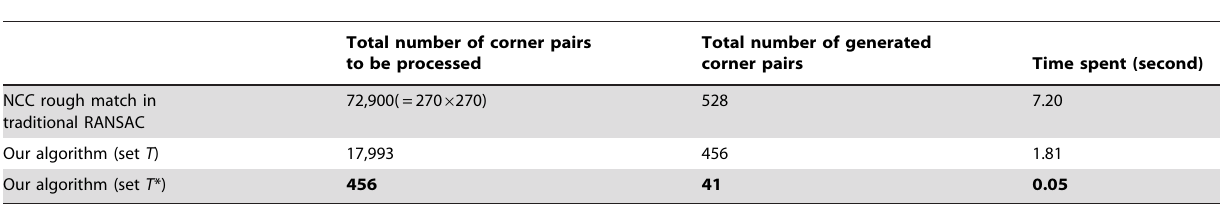
Figure 5. The second experiment on the corner matching efficiency: (a) Selected corners (using our algorithm) from two original images; (b) Corner matching by traditional RANSAC algorithm (NCC rough match); (c) Initial set of matching-corner pairs in our algorithm; (d) Final set of matching-corner pairs in our algorithm. doi:10.1371/journal.pone.0081182.g005 using a geometric hypothesize-and-test architecture. The authors successfully applied the pose estimation method to video from aerial, automotive, and handheld platforms. Table 1. Efficiency comparison between traditional RANSAC and our algorithm